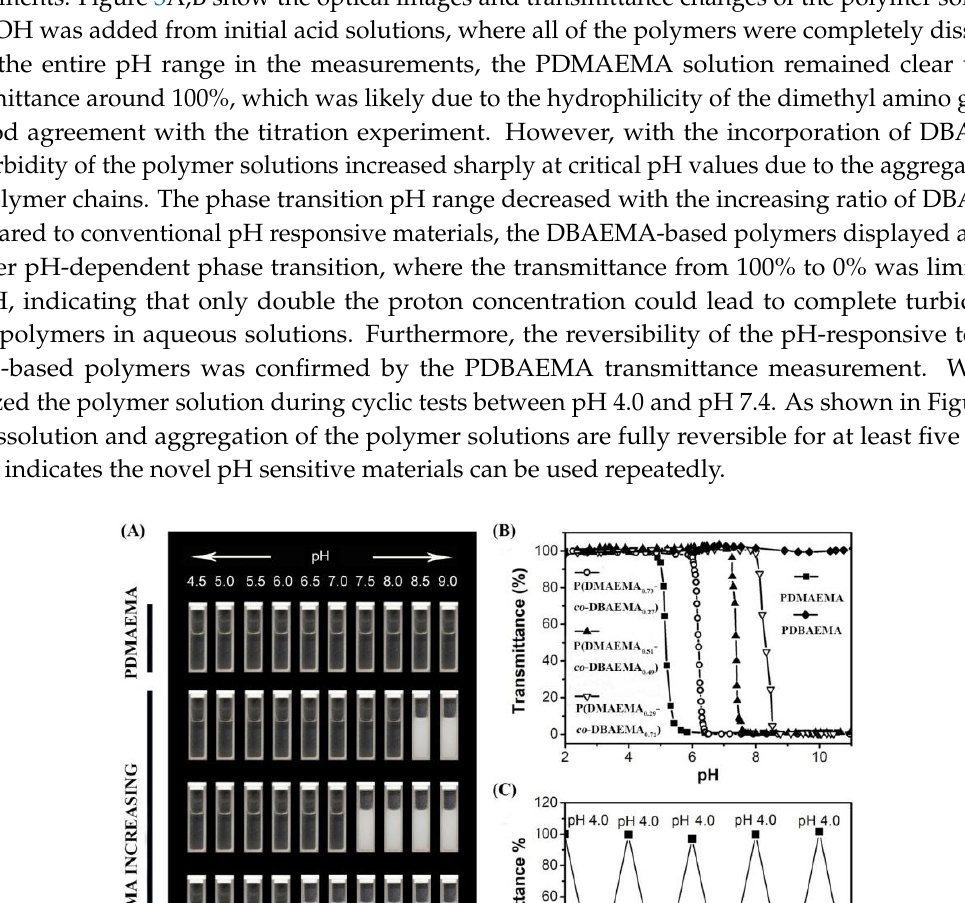
Figure 4. 1 H-NMR spectra of ( A ) P(DMAEMA 0.73 - co -DBAEMA 0.27 ) and ( B ) PDBAEMA at different pH in D 2 O.